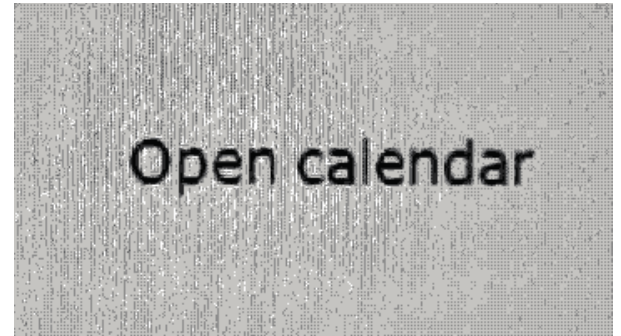
Figure 14. Preprocessed